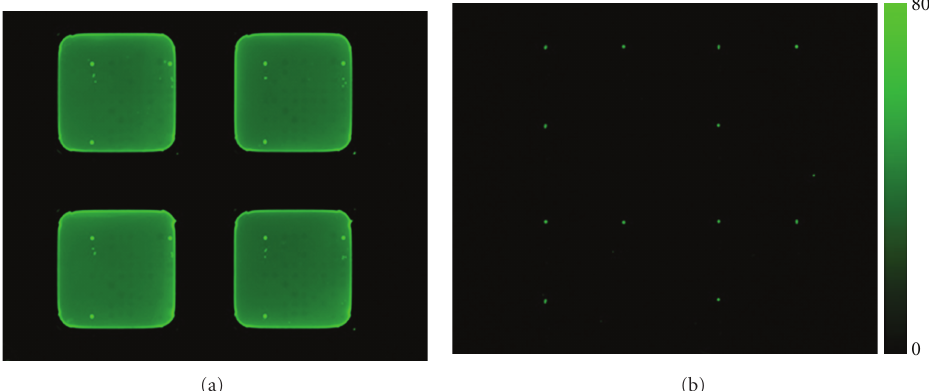
Figure 3: (a) Nitrocellulose- (b) epoxy-coated slides. Both show images of a RPPM after blocking with 10% skim milk for 1 hour at 4 ◦ C. (b) shows almost no background, whereas nitrocellulose (a) has a high background.